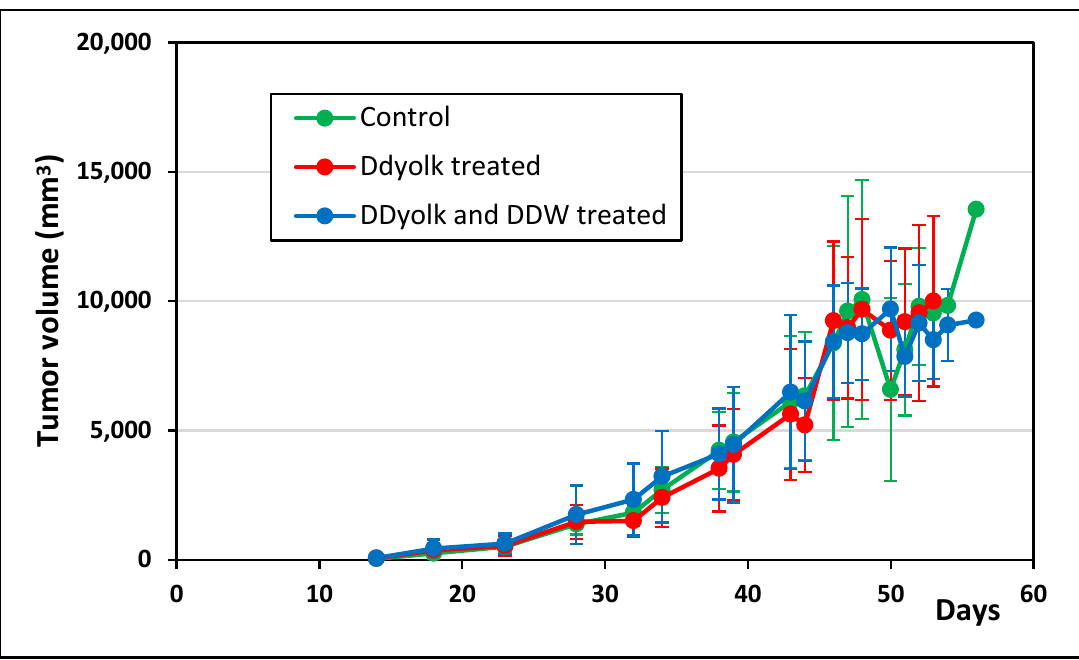
Figure 4. Changes of primary tumor volume in the control and the two treated groups inoculated with the MCF-7 cell line. The primary tumor in the mammary pad was first palpable on day 11.